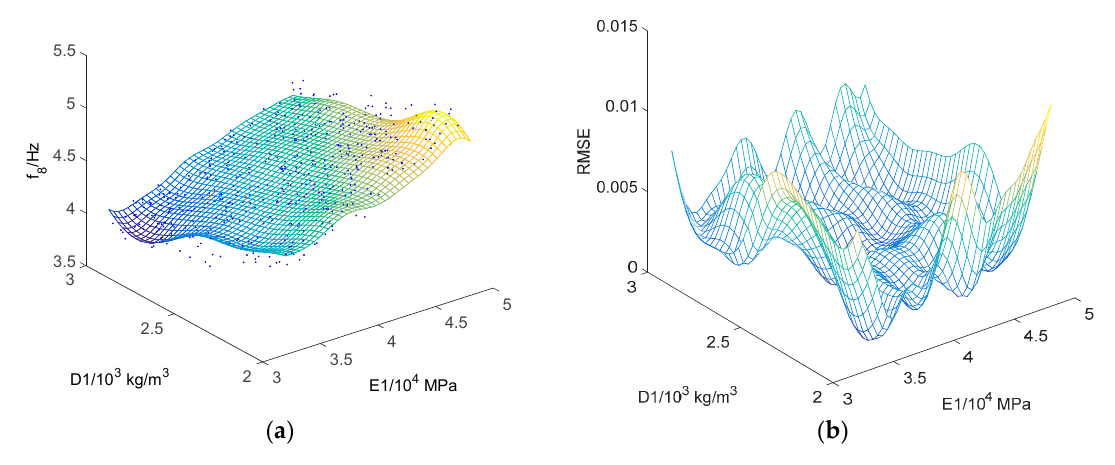
Figure 5. The kriging surrogate model: ( a ) f a,ini of mode 8 (4.421 Hz) in the function of D1 and E1, ( b ) the corresponding RMSE.